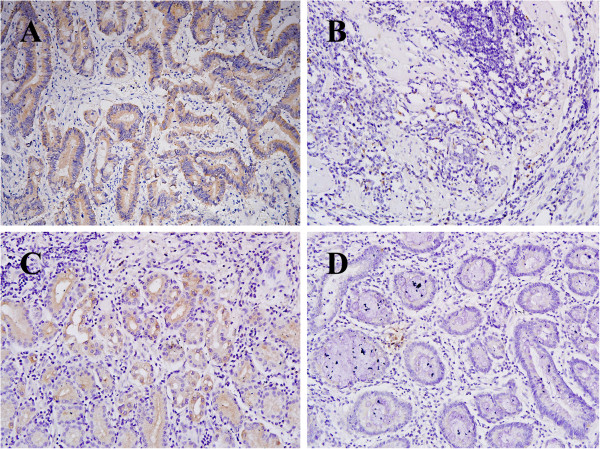
Representative IHC staining (SP × 100). A: Positive labeling for MACC1 with brown stained cytoplasm is shown in primary gastric carcinoma. B: Negative staining for MACC1 is shown in primary gastric carcinoma. C: MACC1 protein expression in adjacent normal tissues D: Negative expression in adjacent noncancerous mucosa.